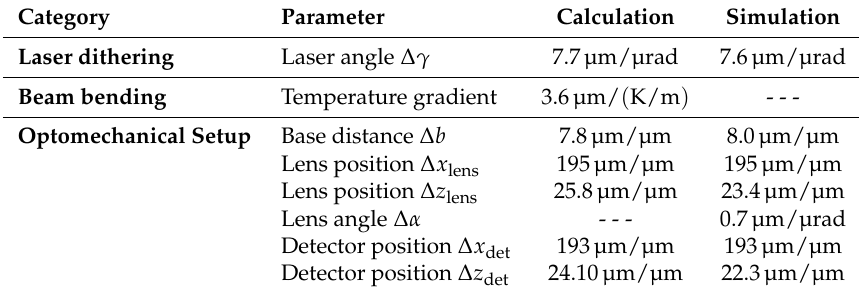
Table 1. Relationship between distance error ∆ d and parameter changes at a measurement distance of d = 1m. For example with a change of the laser angle by ∆ γ = 1µrad, the calculated distance changes by ∆ d =